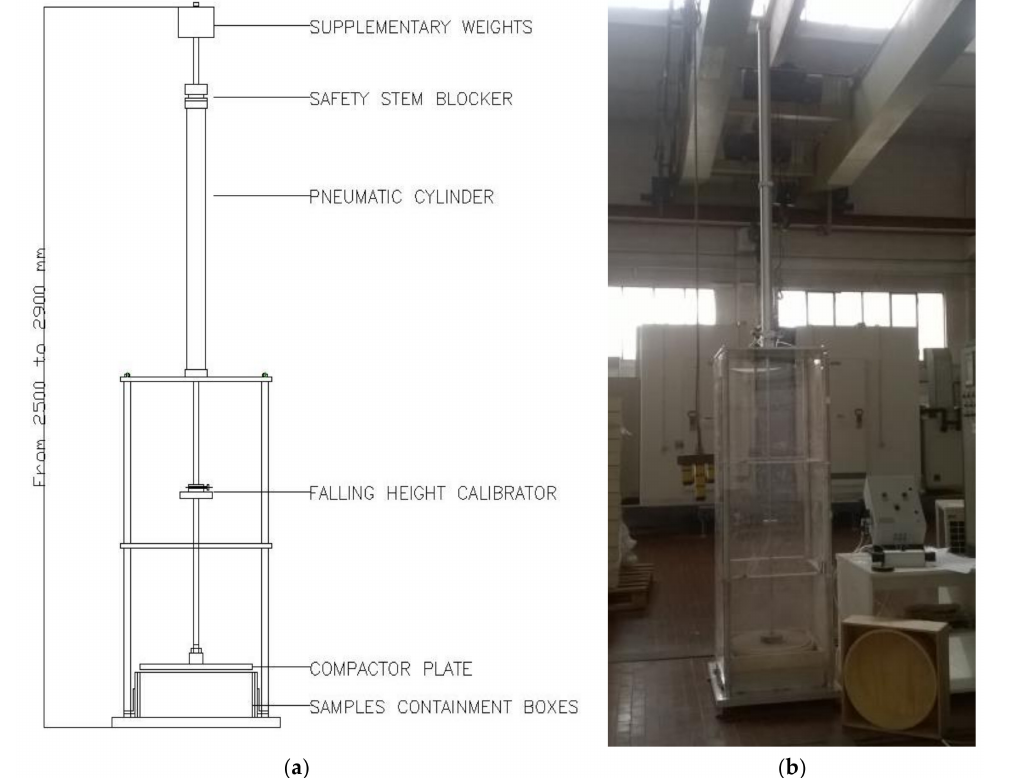
Figure 5. Pneumatic compactor scheme ( a ) and laboratory prototype ( b